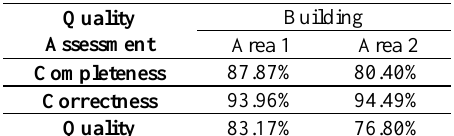
Table 2: Evaluation results of building detection